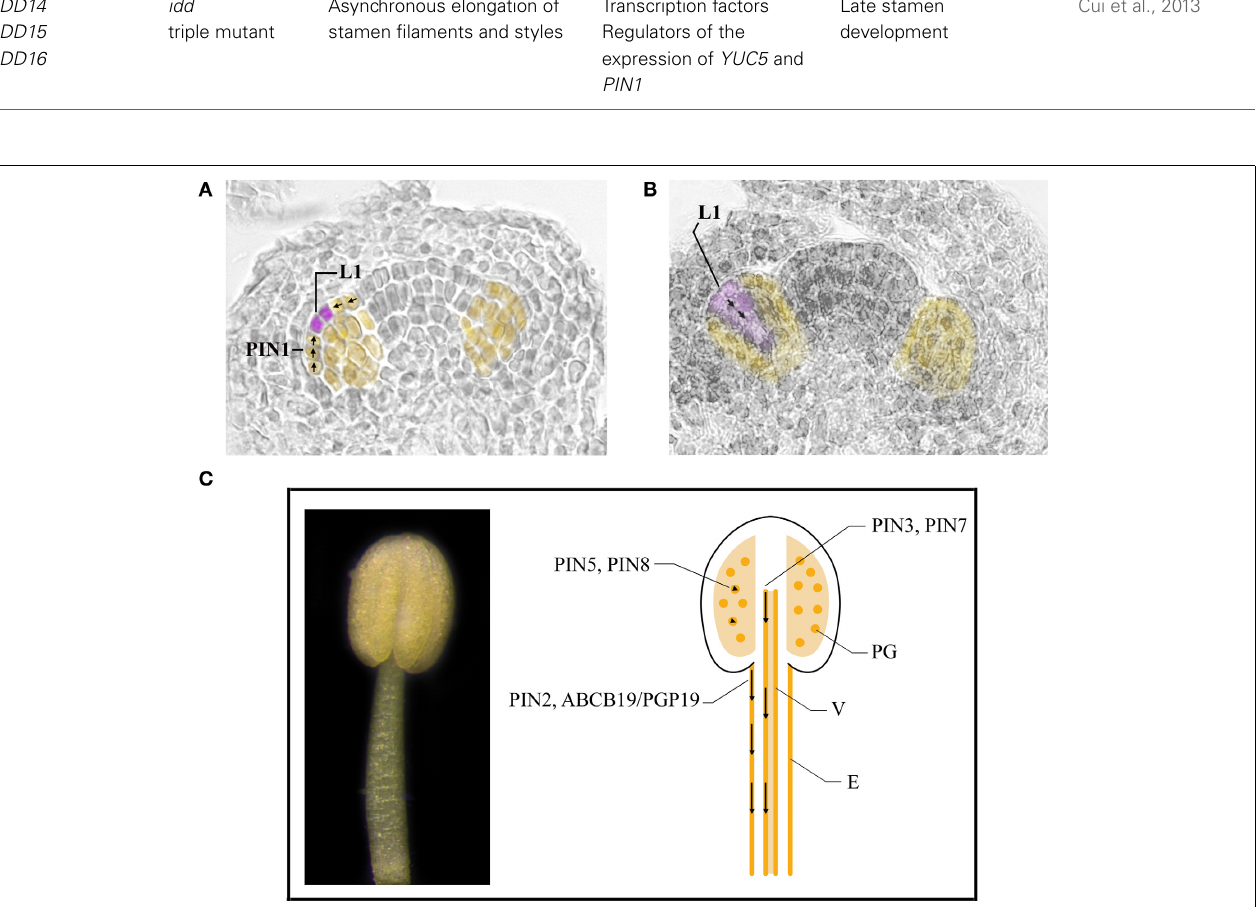
FIGURE 3 | Auxin transport in stamens during early and late developmental stages. (A,B) Stamen primordia (yellow) at stage 5 (A) and 6 (B) of flower development. Places of auxin accumulation are depicted in purple. Presumptive routes of auxin transport are depicted by black arrows. (C) A stamen at stage 11 of flower development (left). Cartoon of a